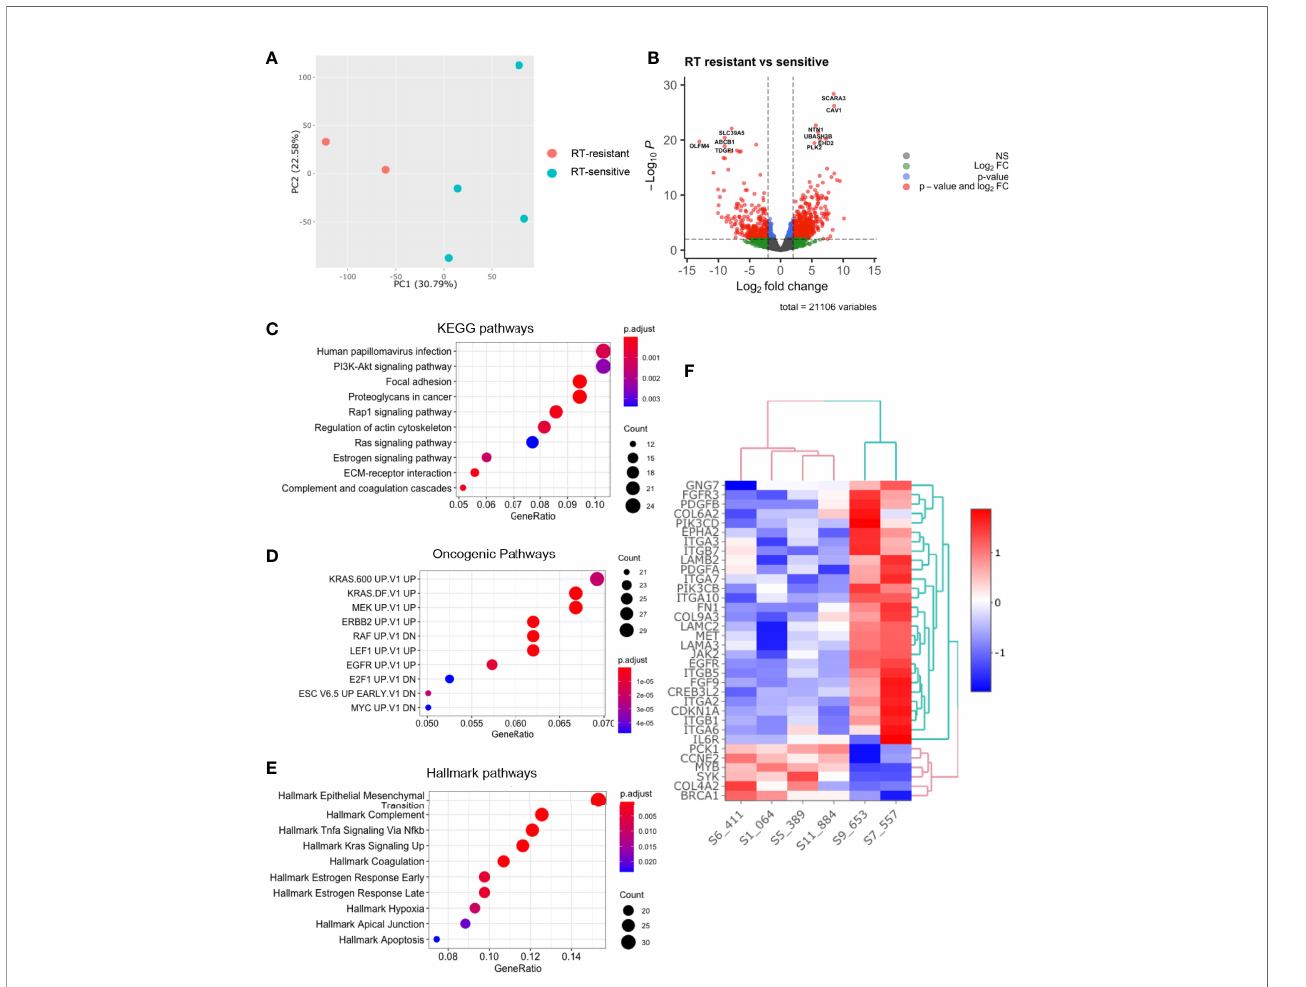
FIGURE 3 | Comparative analysis of baseline transcriptomes of radiation-sensitive and radiation-resistant PDO lines. (A) Principal component analysis; (B) Volcano plot of upregulated and downregulated genes in radioresistant PDOs; Gene set enrichment analysis using (C) KEGG pathways, (D) Oncogenic Pathways and (E) Hallmarks pathways gene sets. (F) Heatmap of upregulated PI3K/AKT/mTOR pathway genes in radioresistant PDOs. (PC=principal component, FC=fold